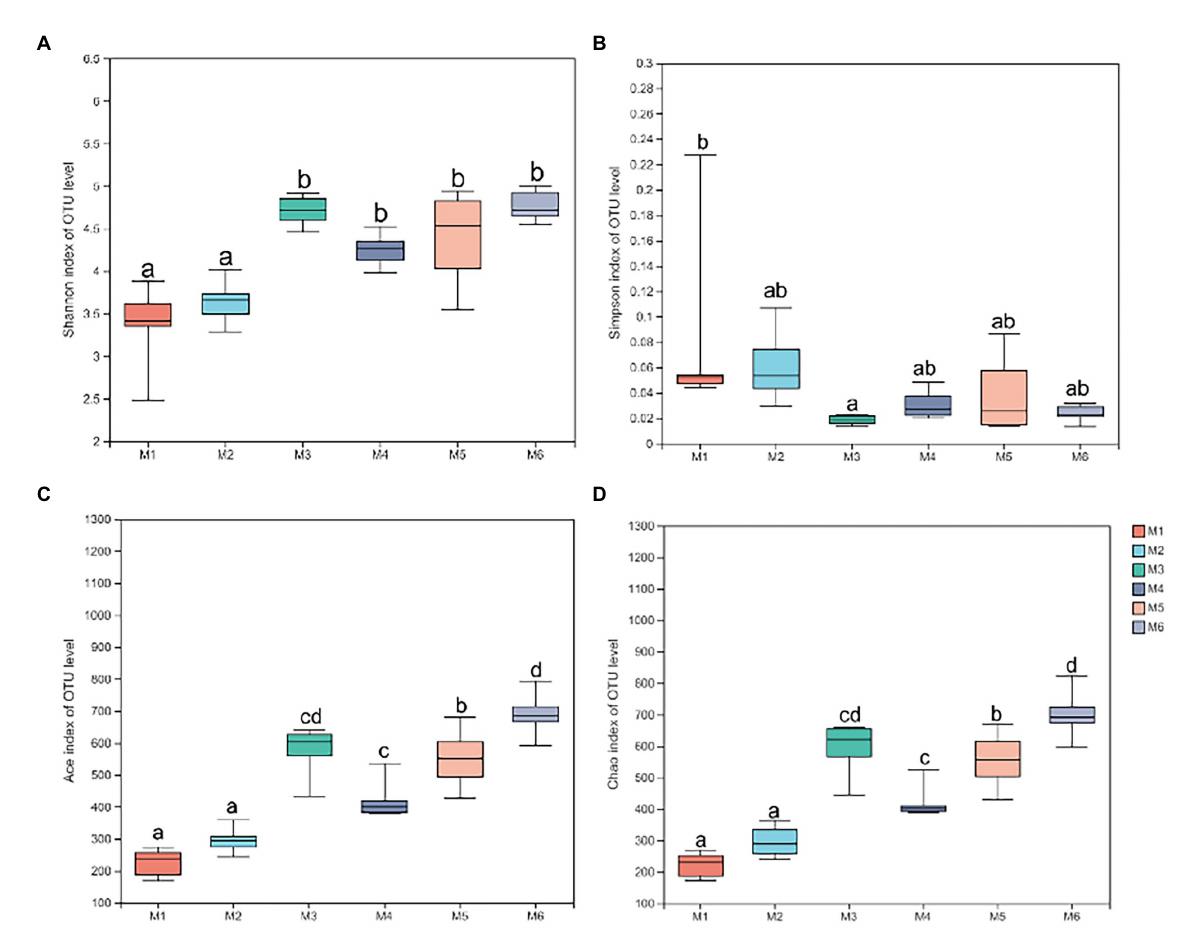
FIGURE 4 Alpha diversity analysis. (A) Shannon index at the operational taxonomic unit (OTU) level. (B) Simpson index at the OTU level. (C) Ace index at the OTU level. (D) Chao index at the OTU level. Data are shown as mean ± SEM. Different lowercase letters indicate significant differences among different groups ( p < 0.05); the number of calves in each of the six groups was